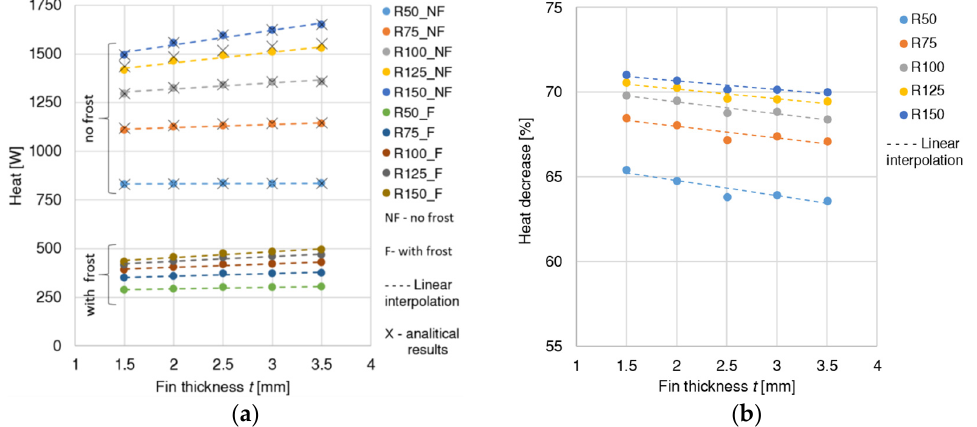
Figure 16. ( a ) Heat transferred through the 1 m length of the finned tube with 8 fins, ( b ) Heat decrease due to frosting.